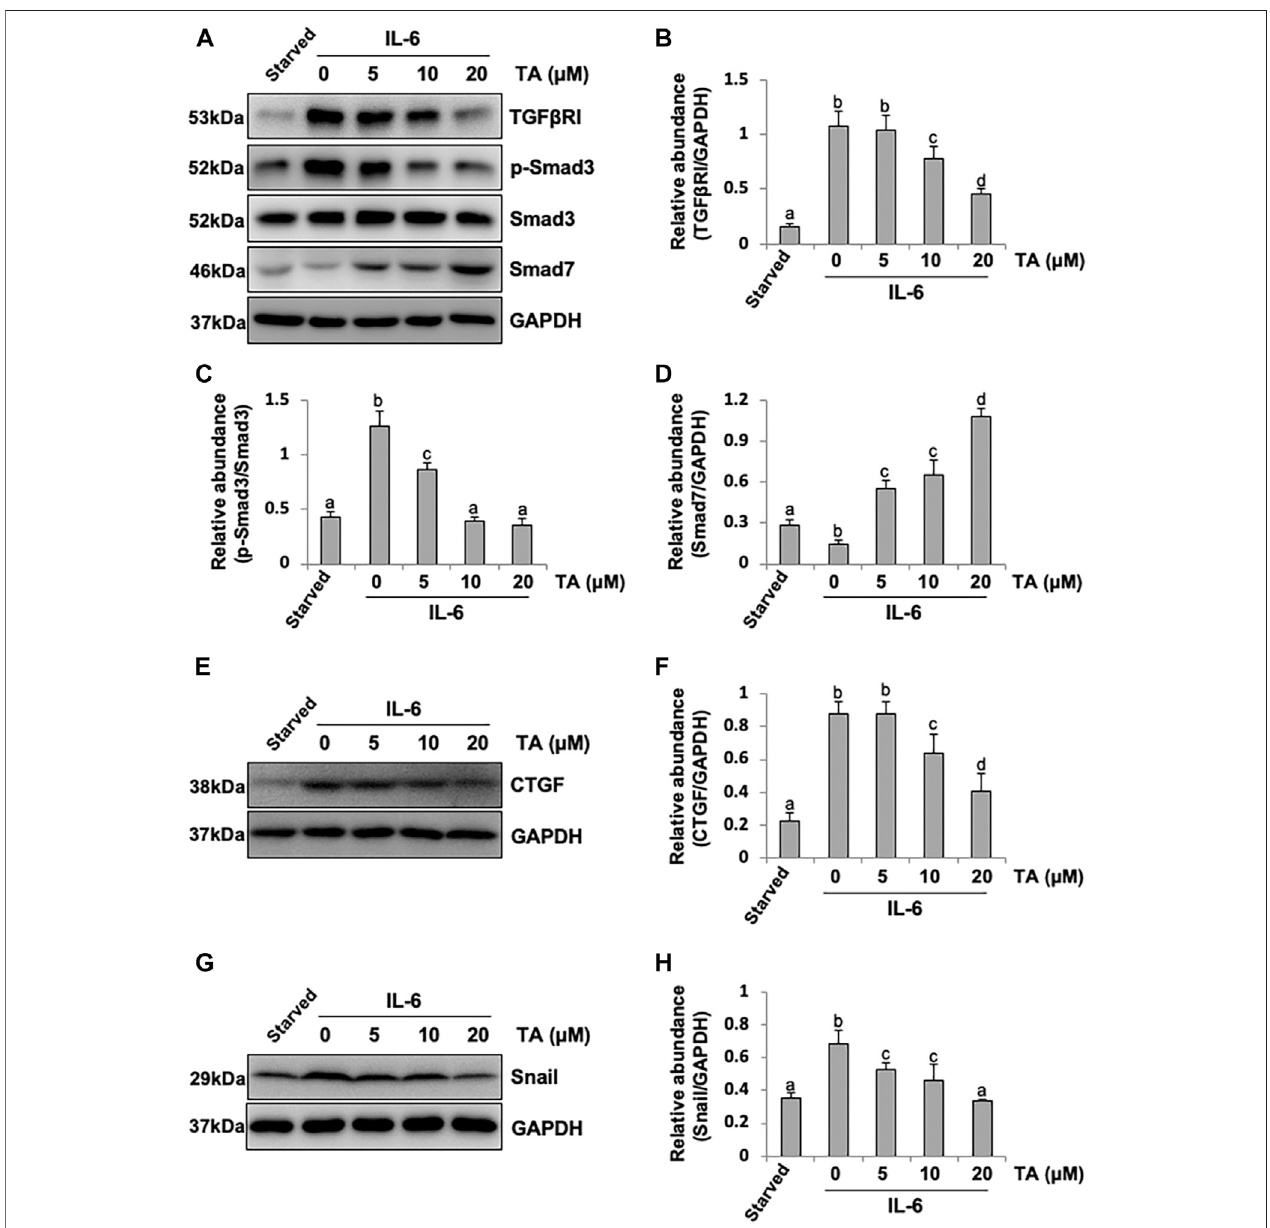
FIGURE 4 | Pharmacological blockade of HDAC6 inhibits the activation of the TGF- β signaling pathway and decreases the expression of CTGF and Snail in peritonealmesothelialcells. (A) Celllysatesweresubjectedtoimmunoblotanalysiswithspeci fi cantibodiesagainstTGF β RI,p-Smad3,Smad3,Smad7,andGAPDH. (B) Expression level of TGF β RI was quanti fi ed by densitometry and normalized with GAPDH. (C) Expression level of p-Smad3 was quanti fi ed by densitometry and normalizedwithSmad3. (D) ExpressionlevelofSmad7wasquanti fi edbydensitometryandnormalizedwithGAPDH. (E) Celllysatesweresubjectedtoimmunoblot analysis with speci fi c antibodies against CTGF and GAPDH. (F) Expression level of CTGF was quanti fi ed by densitometry and normalized with GAPDH. (G) Cell lysates were subjected to immunoblot analysis with speci fi c antibodies against Snail and GAPDH. (H) Expression level of Snail was quanti fi ed by densitometry and normalized with GAPDH. Data are represented as the mean ± SEM (n (cid:1) 3). Means with different superscript letters are signi fi cantly different from one another ( p < 0.05).